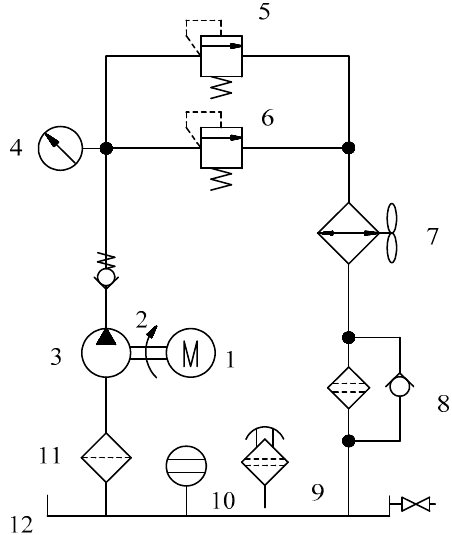
Figure 12. The figure is the schematic diagram of the test bed. 1—motor; 2—coupling; 3—pump; 4—pressure gauge; 5—high pressure relief valve; 6—relief valve (relief valve); 7—air cooler; 8—oil return filter; 9—air filter; 10—level gauge; 11—filter; 12—fuel tank. The assembled test device is shown in Figure 13.